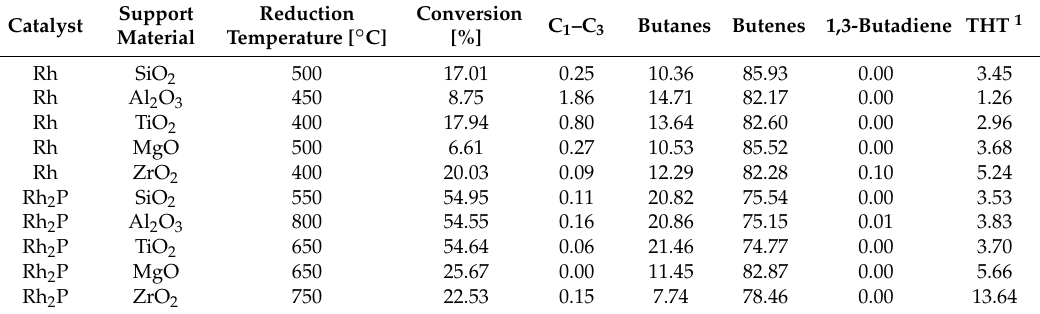
Table 6. Effect of the support material on the performance of Rh 2 P in the HDS of thiophene (fixed-bed